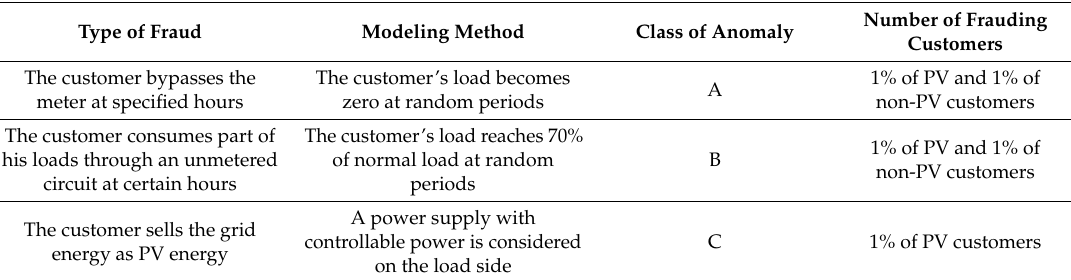
Table 5. Modeling anomaly of customers connected to smart meters.